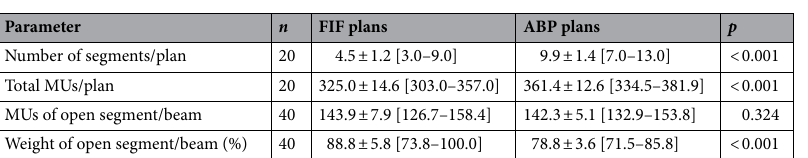
Table 3. Comparison of beam parameter. FIF, Field-in-field technique; ABP, automated breast planning; MUs, monitor units. Data are presented as the mean ± standard deviation [range]. The p values are from the paired t